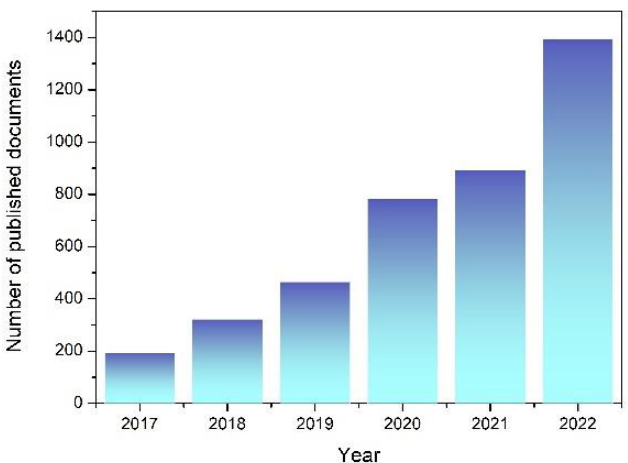
Figure 1. Number of published papers on the https://app.dimensions.ai/ database with the search of “hydrogel for self-powered tactile sensor” (the data were accessed on 1 February 2023).